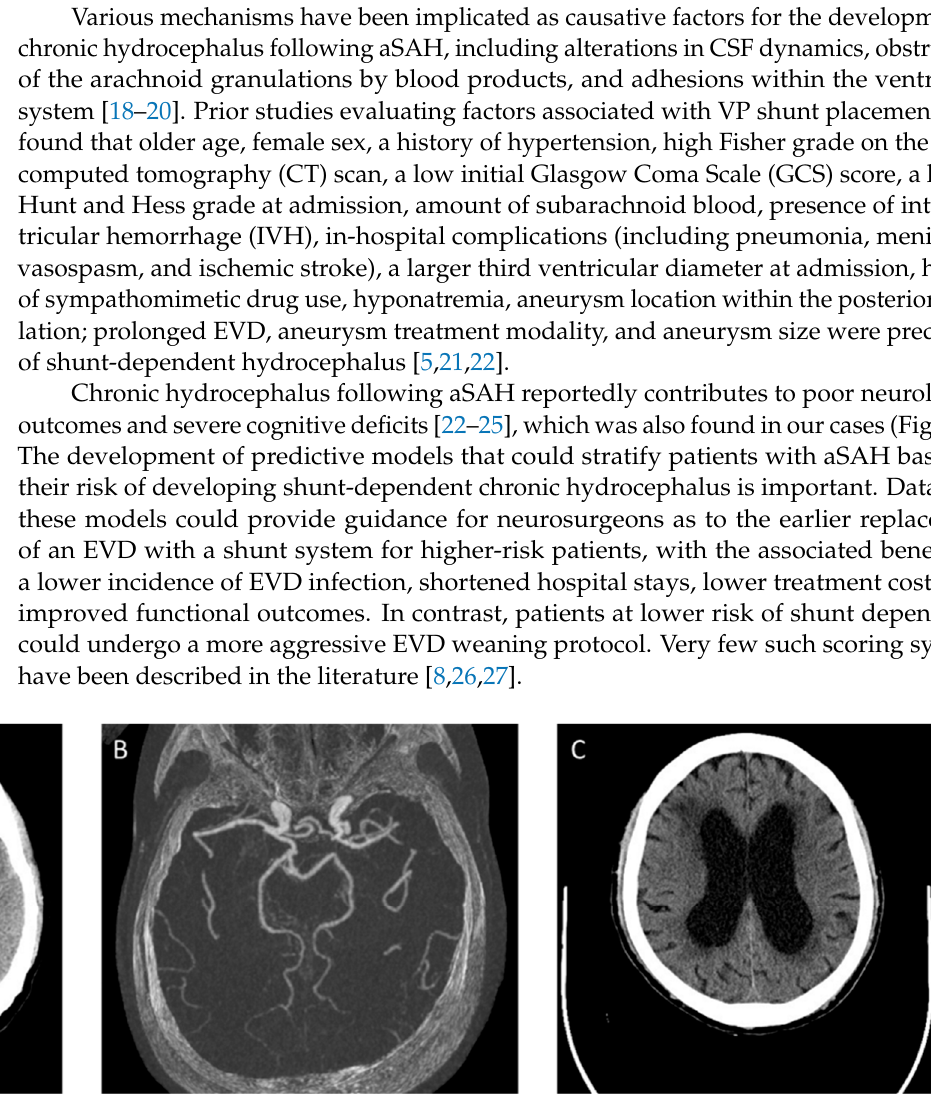
Figure 1. The series of computed tomography (CT) images of a case with aSAH. ( A ) A 68 years-old female patient presented with SAH at admission. There is no IVH and no acute hydrocephalus; ( B ) a ruptured left posterior communicating artery aneurysm was identified and coiled; ( C ) on 12 days after aSAH, CT showed hydrocephalus. She developed progressive ataxia and cognitive dysfunction.